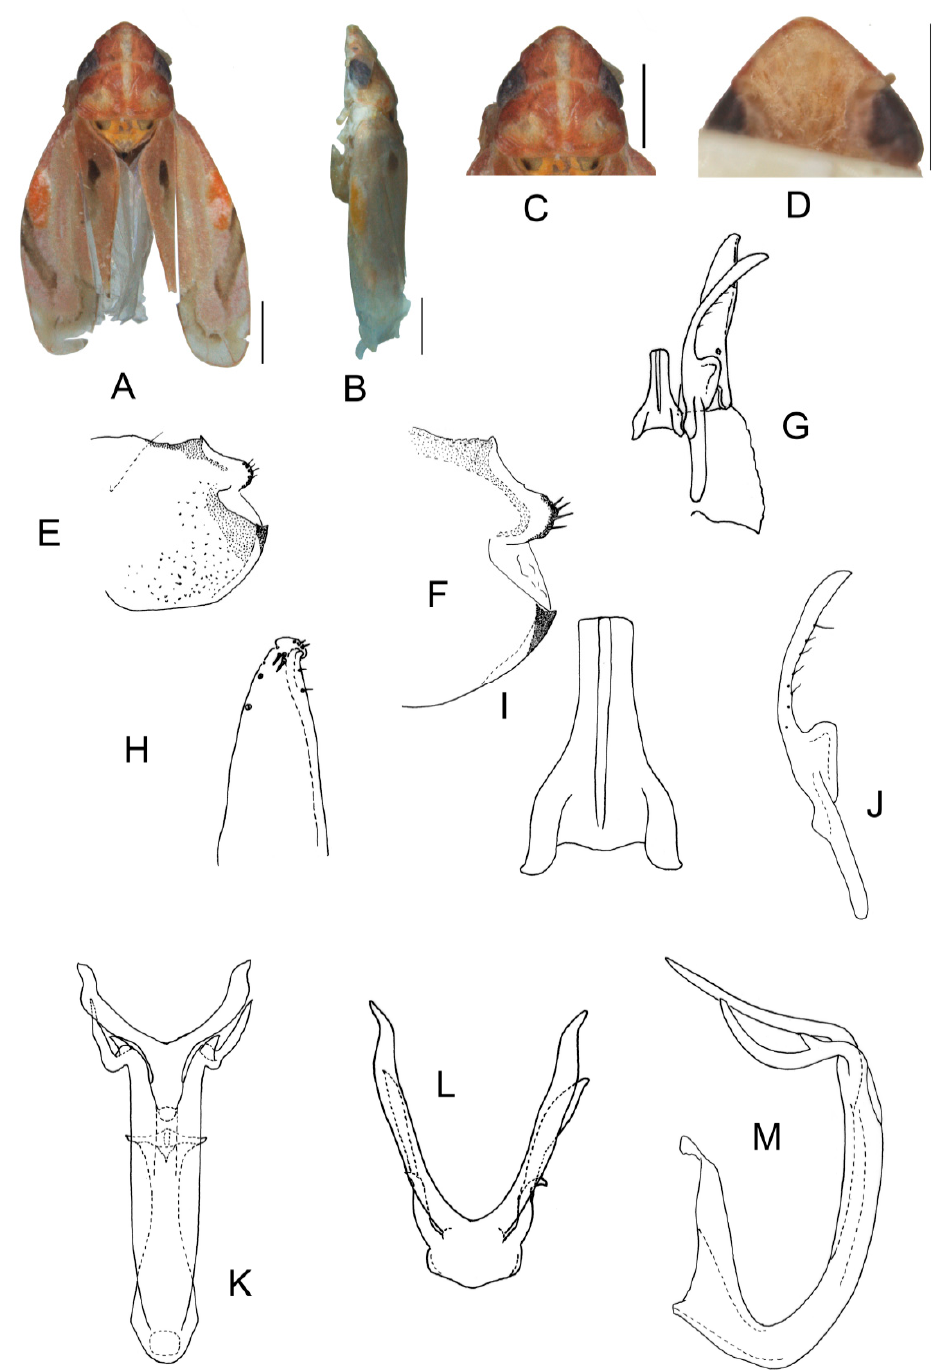
Figure 18. Eurhadina ( Singhardina ) lata sp. nov. : ( A ) habitus, dorsal view; ( B ) habitus, lateral view; ( C ) head and thorax, dorsal view; ( D ) face; ( E ) male pygofer side, lateral view; ( F ) hind part of pygofer, lateral view; ( G ) subgenital plate, connective, paramere and sternite IX, dorsal view; ( H ) apex of subgenital plate, dorsal view; ( I ) connective, dorsal view; ( J ) paramere, dorsal view; ( K ) aedeagus, posterior view; ( L ) apex of aedeagal shaft, dorsal view; and ( M ) aedeagus, lateral view. Scale bars: 0.5 mm. Body and face reddish orange. Crown with a creamy longitudinal fascia, remainder reddish orange. Pronotum with a creamy longitudinal fascia and two triangular patches posteriorly, remainder reddish orange. Basal triangles pale yellowish, scutellum creamy with apex blackish, two blackish marks on sides of scutellum and an orange patch